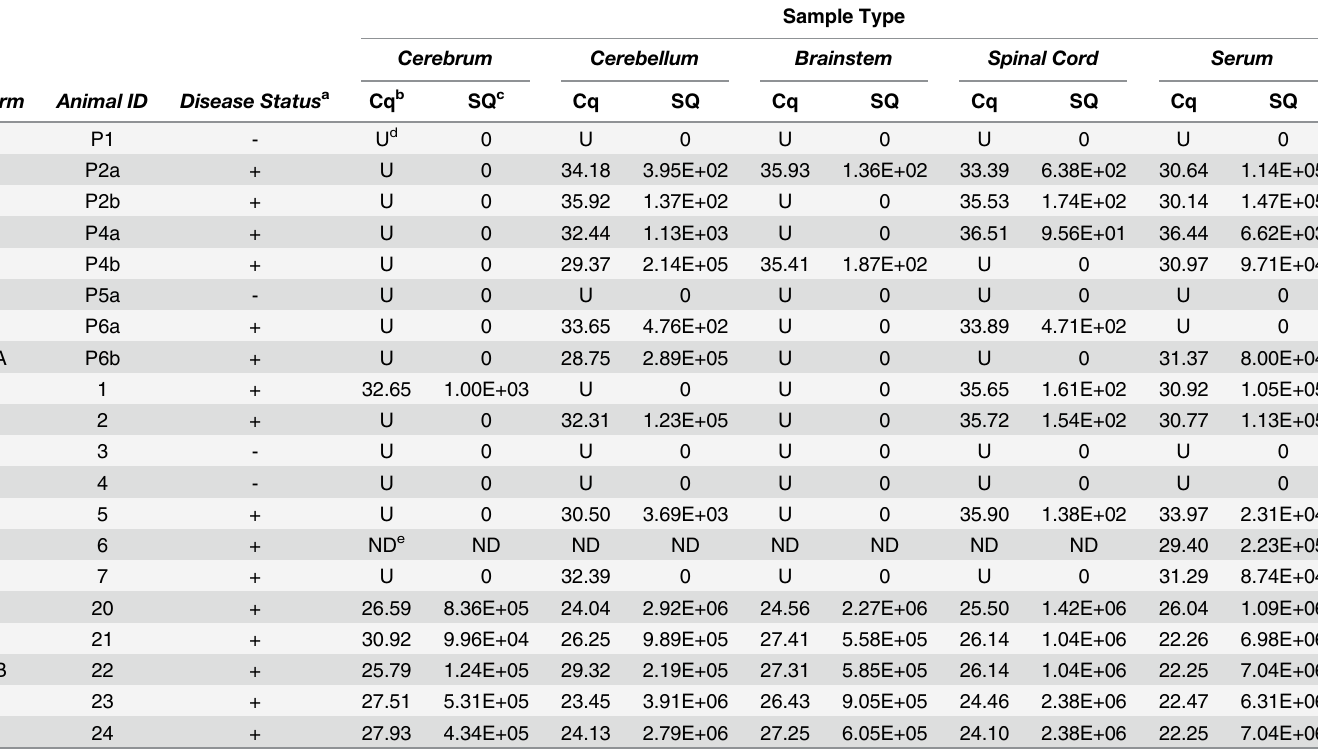
Table 2. Quantitative Real-time PCR Results from Piglet Samples from Farm A and Farm B.